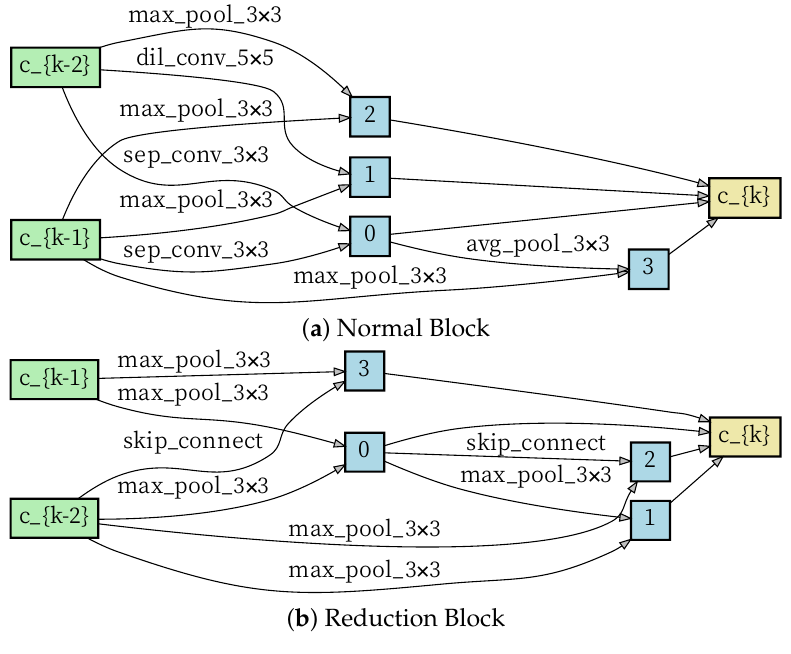
Figure 5. The normal and reduction block learned by SACN in the second